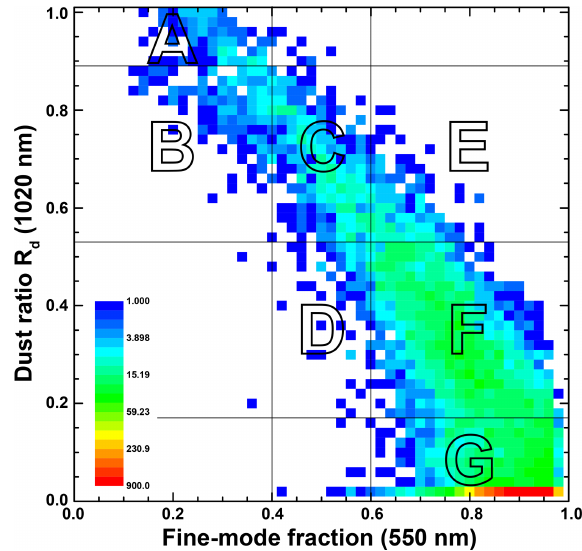
Figure 4. Two-dimensional histograms of R d derived using PLDR at 1020nm and FMF at 550nm for the considered AERONET sta- tions over East Asia. Seven sectors, A to G, are defined according to the ranges of PLDR and FMF: pure dust (sector A), dust-dominated mixture (sectors B, C, and E), pollution-dominated mixture (sectors D and E), and pollution (sector G). The colour coding indicates the number of observation data in log